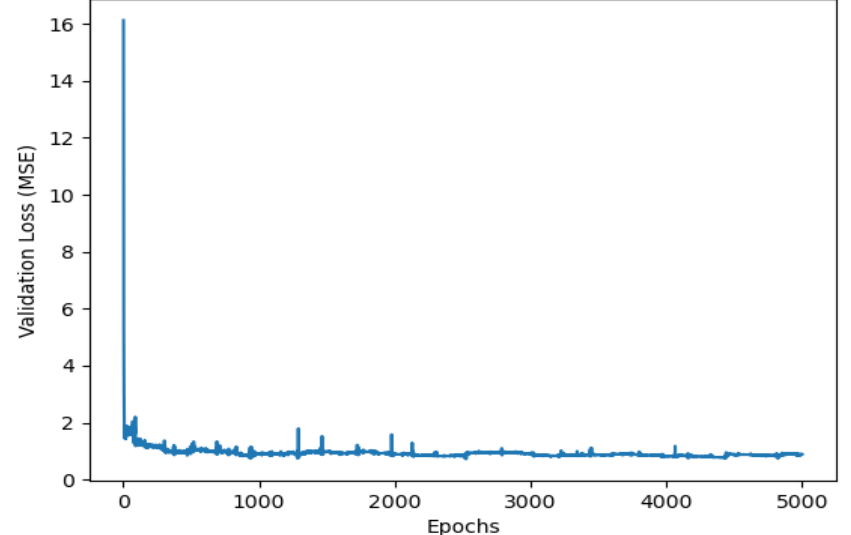
Figure 14. Average validation MSE in Four-fold cross-validation experiment for bimodal deep